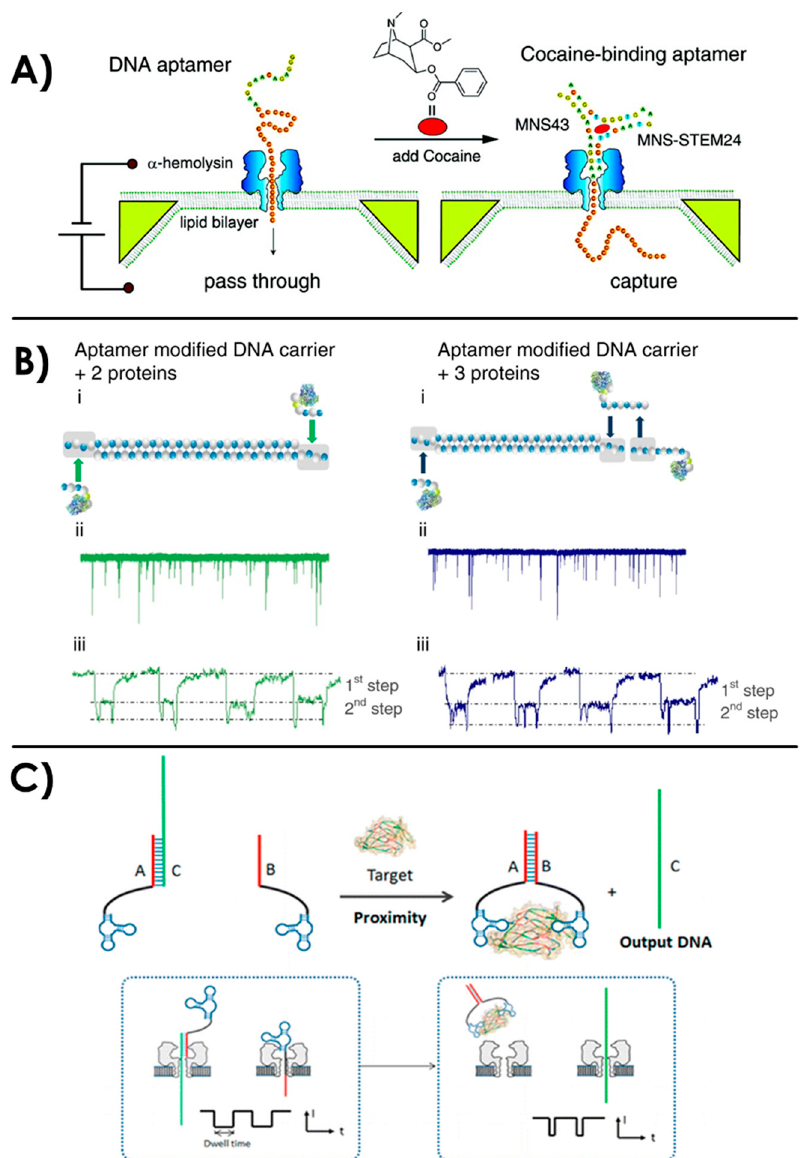
Figure 5. ( A ) Nanopore detection of cocaine with aptamers in solution. Reprinted adapted with permission from [156]. Copyright 2011 American Chemical Society. ( B ) “DNA bar-coding” of a DNA carrier with several aptamers for the specific detection of proteins thanks to the analysis of intra-events [157]. ( C ) Detection of a relatively big target with the release of an intermediate DNA sequence during the aptamer recognition of the target. Reprinted adapted with permission from [158].